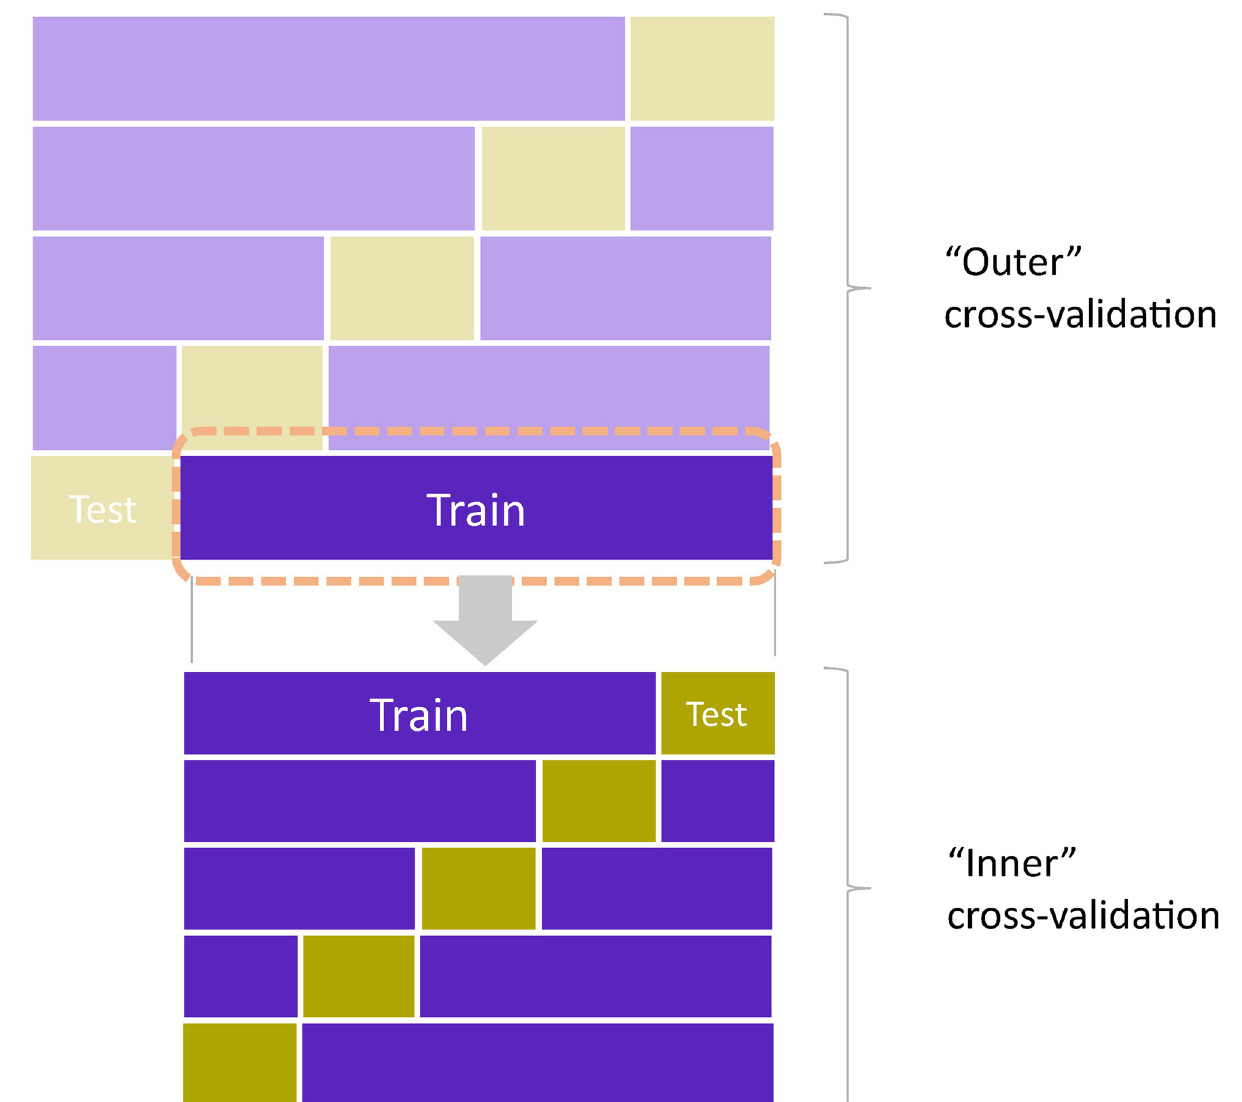
Fig 3. Schematic description of nested cross-validation. The “inner” cross-validation: The “inner” cross-validation is for model selection based on their accuracy with unseen data. Here, the models are repeatedly fitted to different random subsets (training data), and their accuracy is evaluated with the data not used for fitting (test data). The model’s accuracy with the test data was averaged through iterations and used for model